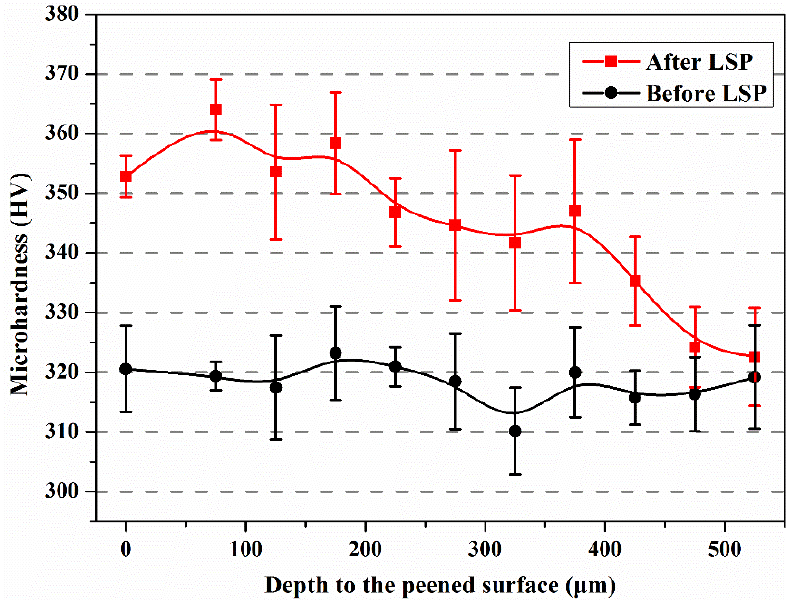
Figure 7. Microhardness of SLM-built Ti64 samples before and after LSP with depth.